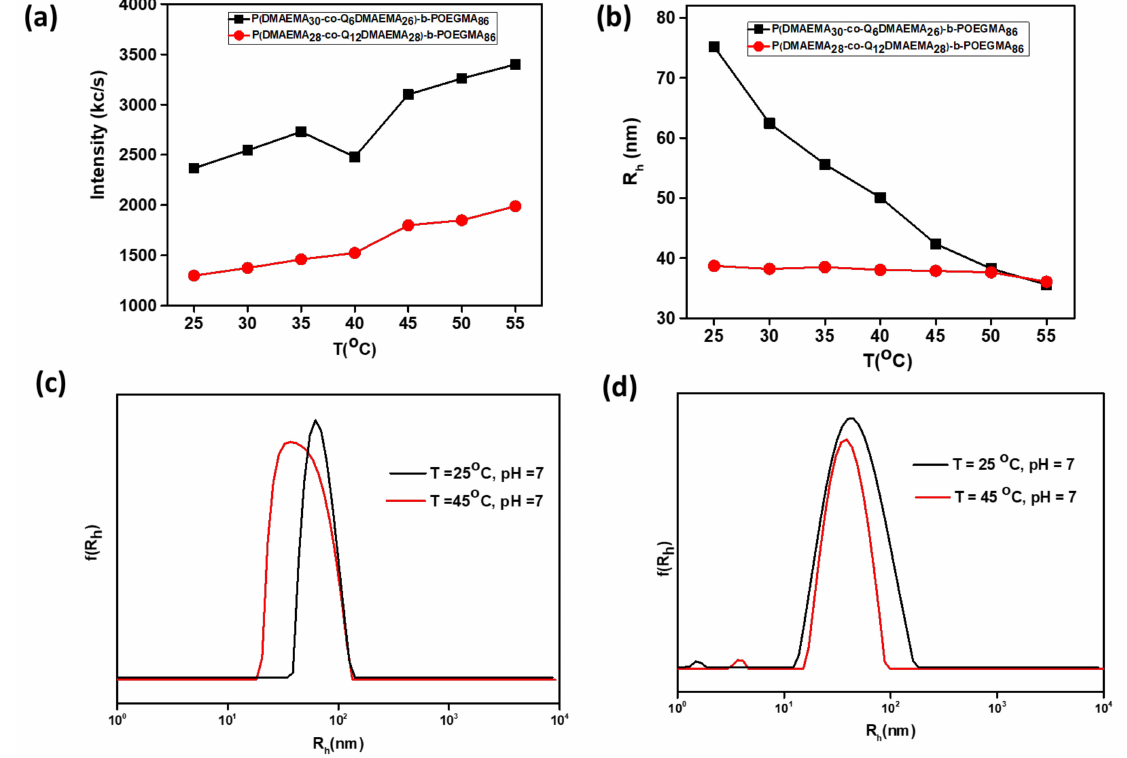
Figure 7. Dependence of ( a ) scattering intensity, ( b ) hydrodynamic radius for the P(DMAEMA 30 -co-Q 6 DMAEMA 26 )- b - POEGMA 86 and P(DMAEMA 28 -co-Q 12 DMAEMA 28 )- b -POEGMA 86 diblocks on temperature and size distributions from CONTIN obtained at 90 ◦ measurement angle, at T = 25 ◦ C, pH = 7 and at T = 45 ◦ C (for ( c ) P(DMAEMA 30 -co-Q 6 DMAEMA 26 )- b -POEGMA 86 and ( d ) P(DMAEMA 28 -co-Q 12 DMAEMA 28 )- b -POEGMA 86